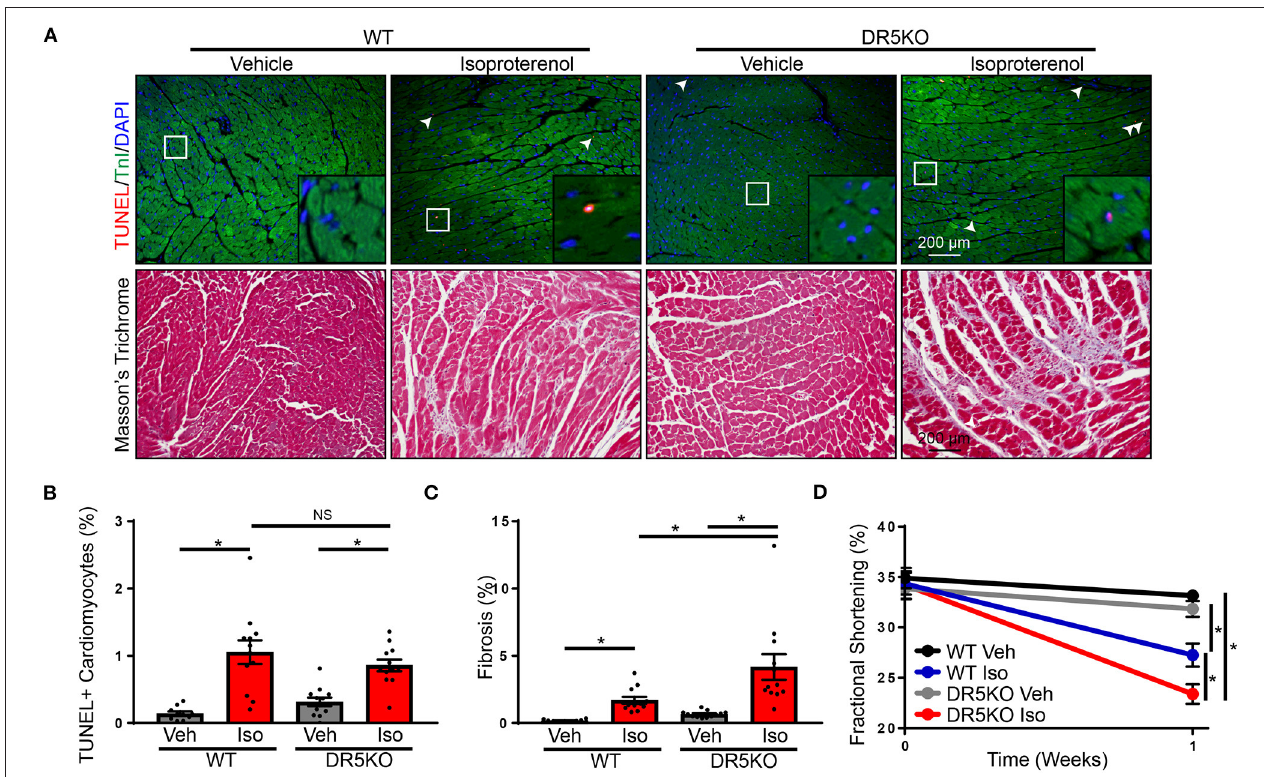
FIGURE 6 | DR5KO exacerbates fibrosis in vivo . (A) Top: Representative TUNEL (red) staining in hearts of WT and DR5KO animals administered vehicle or isoproterenol. Cardiomyocytes were identified by troponin I (TnI) staining (green) and nuclei were labeled using DAPI (blue). TUNEL positive nuclei are indicated by white arrows. Bottom: Representative Masson’s trichrome staining showing fibrosis (blue) in hearts from vehicle and isoproterenol treated WT and DR5KO mice. (B) Quantification of TUNEL positive cardiomyocytes from WT and DR5KO mice administered vehicle or isoproterenol. n = 10 for WT vehicle, 12 for DR5KO vehicle, WT isoproterenol, and DR5KO isoproterenol, Two-Way ANOVA, * p < 0.05 vs. vehicle. (C) Quantification of fibrotic area from Masson’s trichrome stained WT and DR5KO hearts after vehicle or isoproterenol treatment. n = 10 for WT vehicle, 12 for DR5KO vehicle, WT isoproterenol and DR5KO isoproterenol, Two-Way ANOVA, * p < 0.05. (D) Fractional shortening was measured echocardiography in WT and DR5KO mice at baseline and with vehicle or isoproterenol infusion. n = 10 for WT vehicle, 12 for DR5KO vehicle, WT isoproterenol and DR5KO isoproterenol, Two-Way ANOVA, * p <